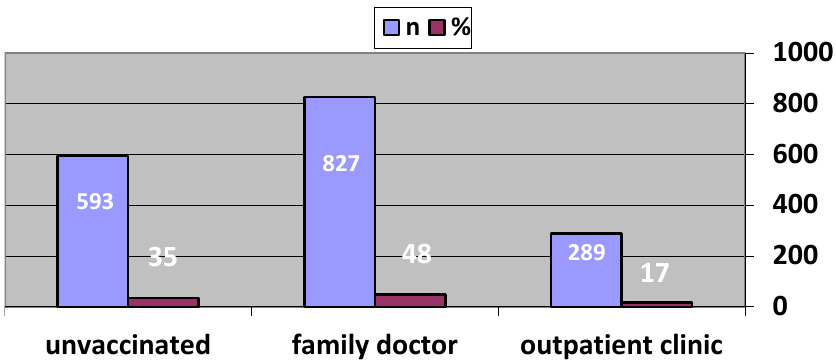
Figure 1. Vaccination preferences of the patients after being informed. Table 1. Basic demographic and clinical characteristics of the patients.